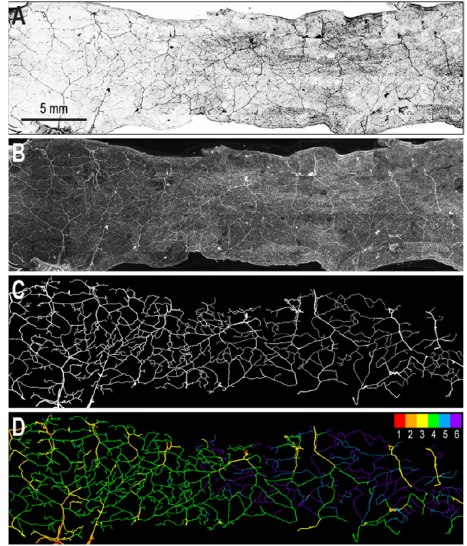
Figure 3. Image processing of a mouse colon vascular pattern . ( A ) Original light microscopy image. ( B ) Image’s background color inversion. ( C ) Image segmentation. ( D ) Identification with VESGEN 2D of six generations of vascular branches (color code in the insert). Bar in A: 5 mm for all images. The original length of the segment in this image is 3.5 cm (from [22]).